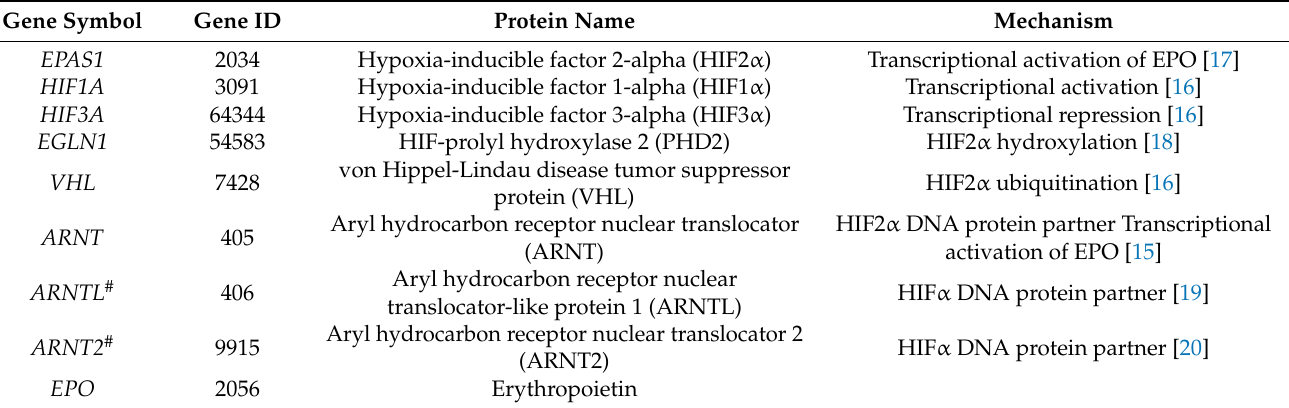
Table 1. Key players of oxygen-sensing pathway and EPO